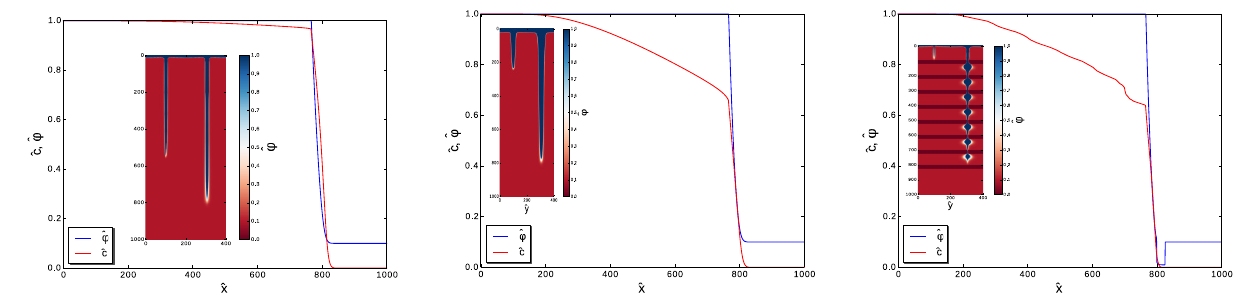
FIGURE 11 | Concentration (red) and porosity (blue) profiles along the line y = 3 / 4 L y , corresponding to the centreline of the winning pipe. Left : non-stratified case at Pe 8, center: non-stratified case at Pe =